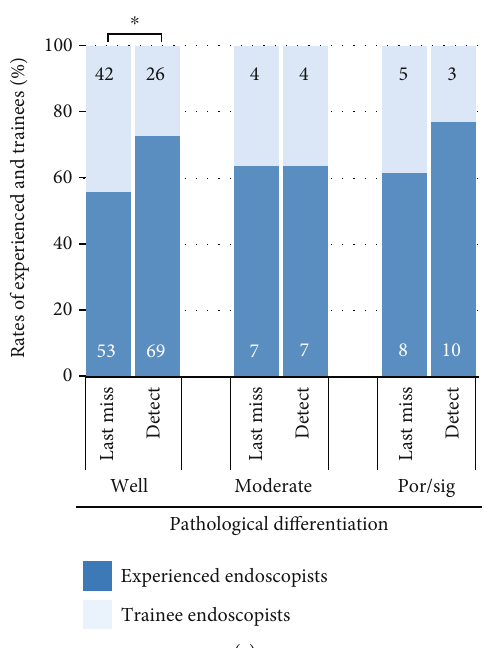
Figure 3: The rates of experienced and trainee endoscopists in the detected and last missed endoscopy of false-negative EGCs regarding (a) circumference, (b) tumor location, (c) tumor morphology, (d) color, and (e) pathological di ff erentiation. The numbers on the graph bars indicate the number of endoscopists in the detected and last missed endoscopy. ∗ P < 0 : 05 , upper: upper stomach; middle: middle stomach; lower: lower stomach; GC: greater curvature; LC: lesser curvature; AW: anterior wall; PW: posterior wall; well: well-di ff erentiated carcinoma; moderate: moderately-di ff erentiated carcinoma; por/sig: poorly-di ff erentiated or signet-ring cell